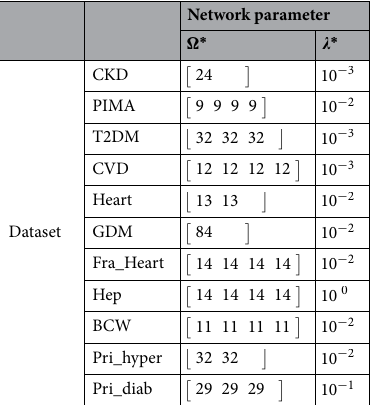
Table 3. Optimal parameter settings for different datasets.